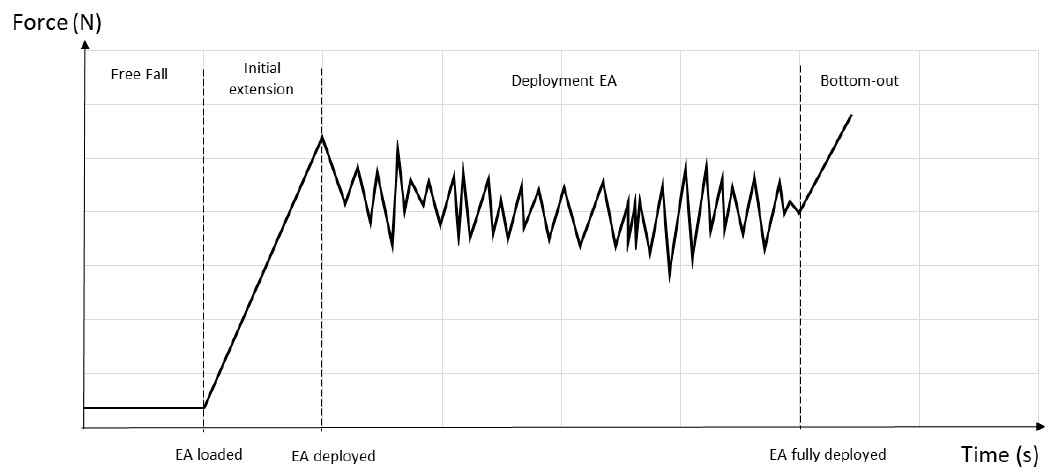
Figure 2. Dynamic performance of an energy absorber (EA) [23].